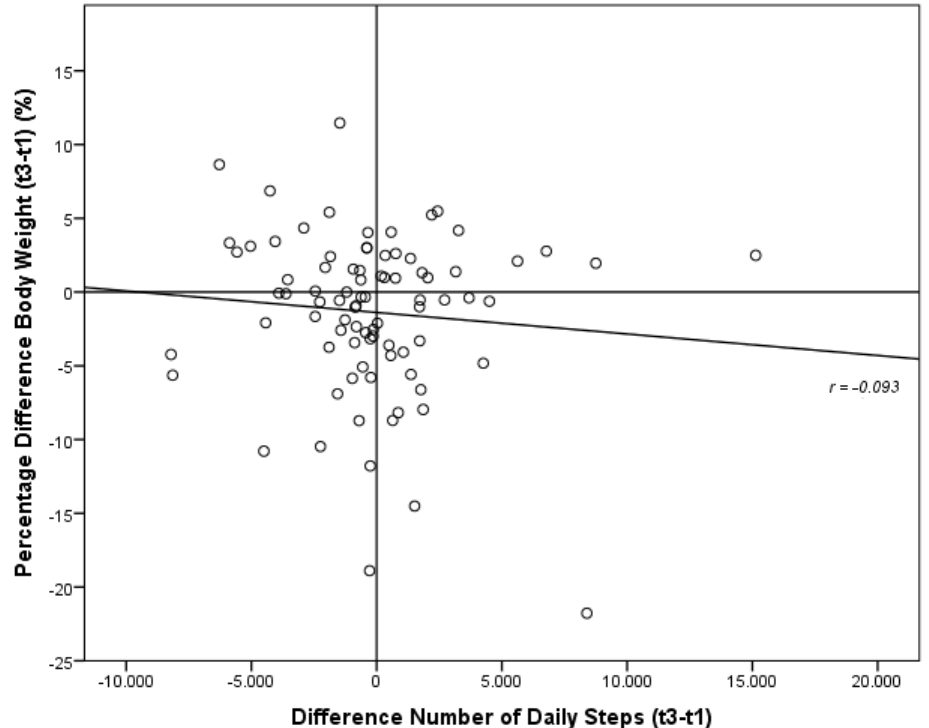
Figure 1. Correlation of the differences of percentage body weight with the difference of body weight-adjusted NEAT between baseline (t1) and six-month follow-up (t3); NEAT: non-exercise activity thermogenesis.